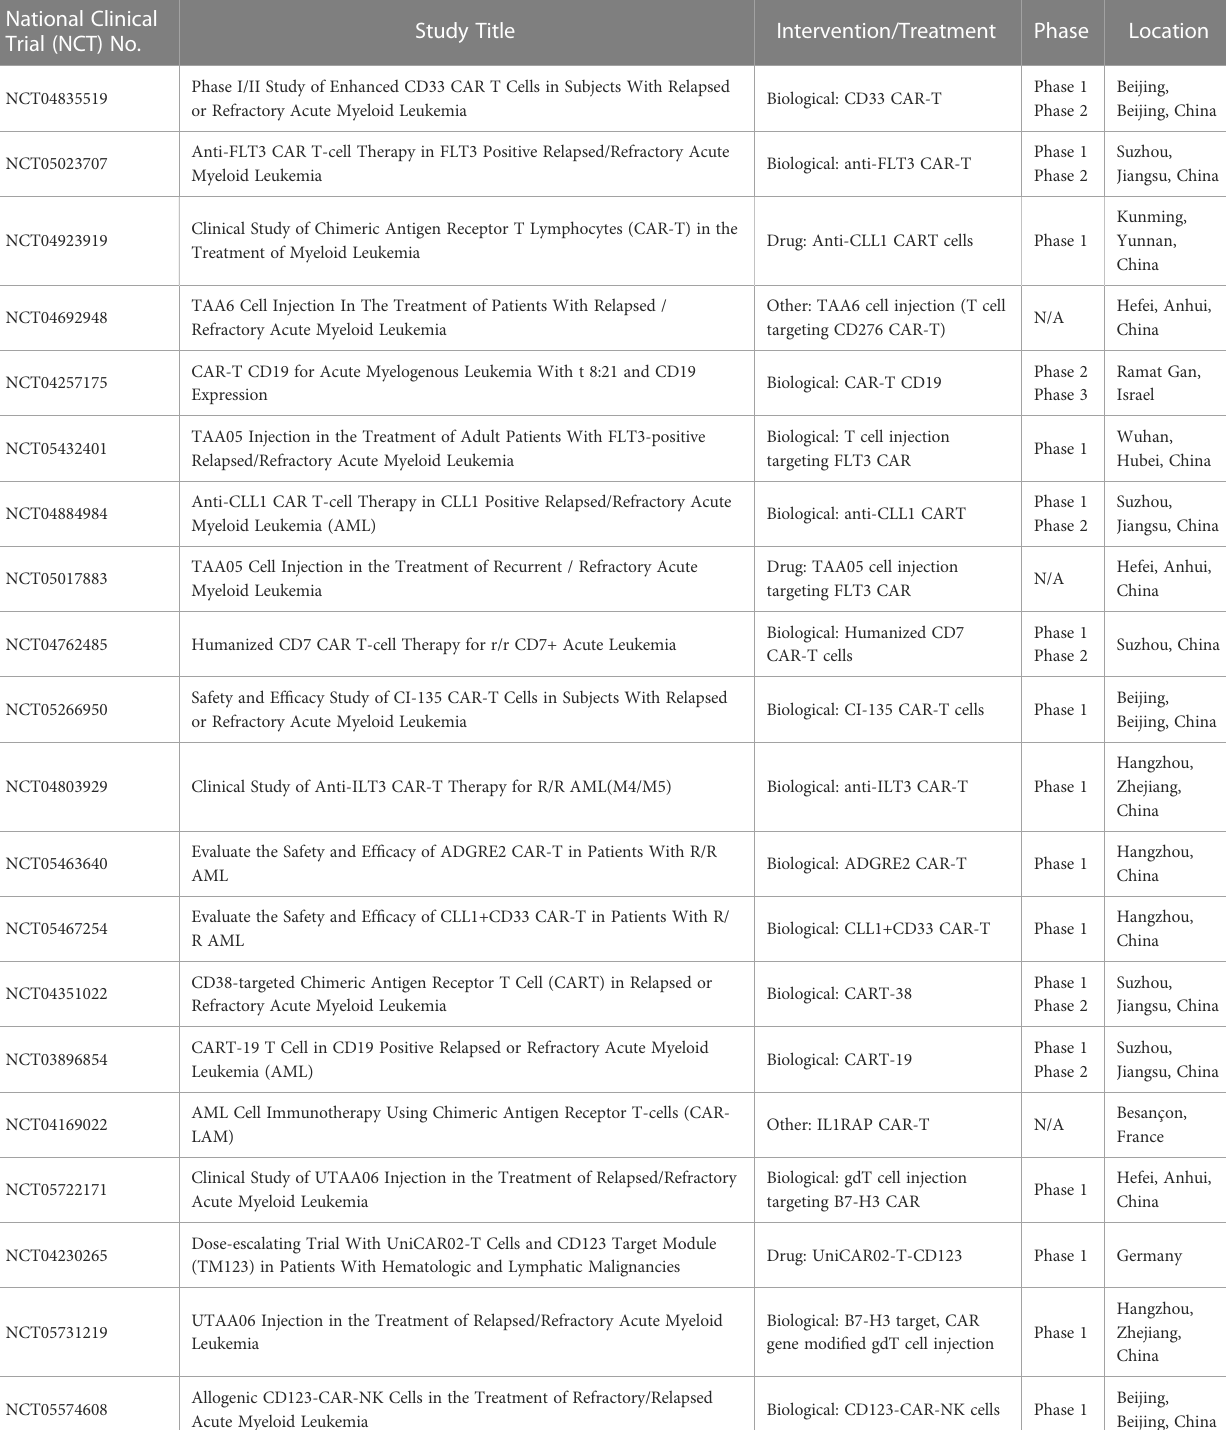
TABLE 4 Ongoing international CAR-T therapy clinical trials for the treatment of relapsed or refractory acute myeloid leukemia. National Clinical Trial (NCT)